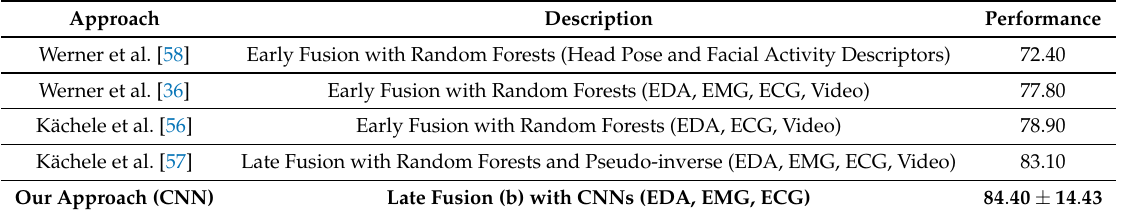
Table 7. Fusion performance comparison to early work on the BVDB (Part A) in a LOSO cross-validation setting for the classification task T 0 vs. T 4 .